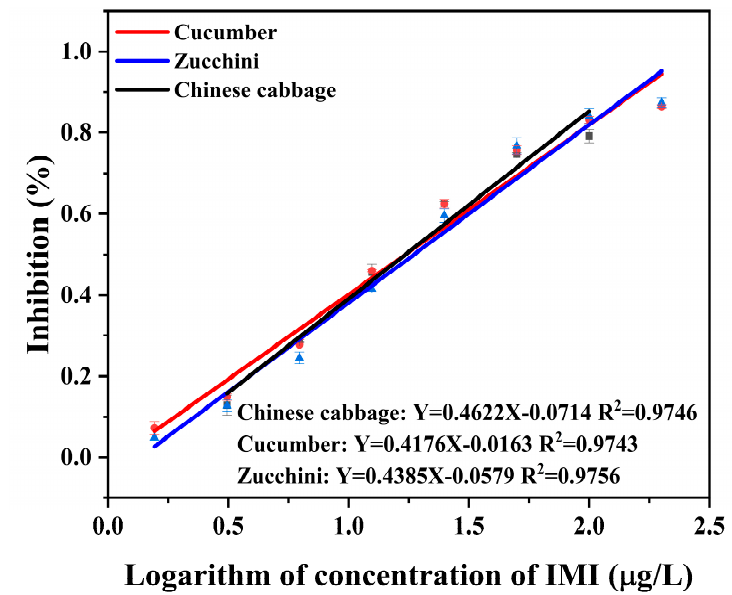
Figure 6. Standard curve for the detection of IMI in vegetable samples (Chinese cabbage, cucumber, and zucchini) using Co-ELISA.